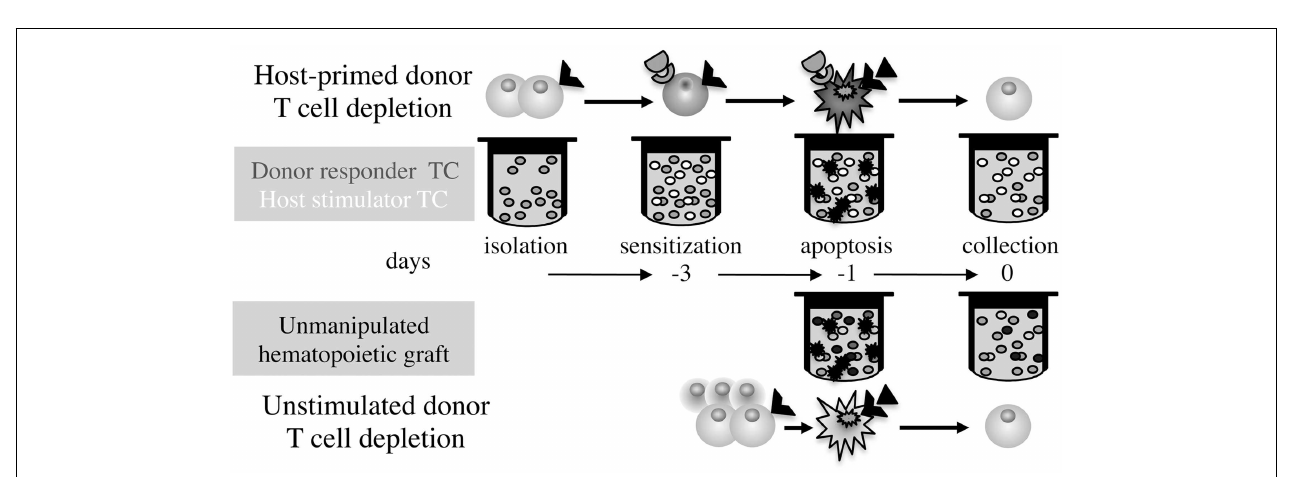
FIGURE 1 | Differential time axis and procedures for GvHD prophylaxis. Ex vivo simulation of GvHD by exposure of isolated donorT cells to irradiated host stimulators followed by depletion of the sensitizedT cells, as compared to elimination of apoptosis-sensitive donorT cells in whole grafts without antigen-specific